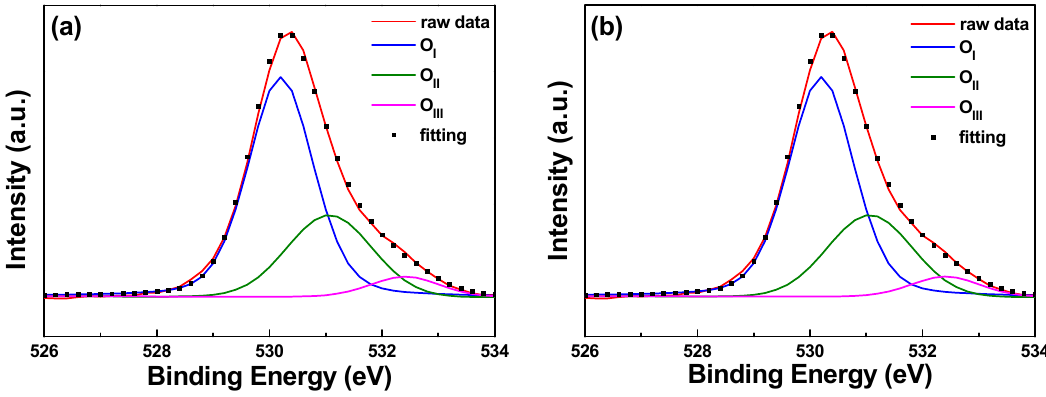
Figure 9. XPS spectra and the Gaussian-resolved components of the O 1s peak of FZO films on unmodified and 30 s pretreated PI substrates. ( a ) Unmodified and ( b ) O 2 plasma pretreatment time of 30 s. Table 1. Area of the O 1s peak of F-doped ZnO (FZO) films on unmodified and 30 s pretreated polyimide (PI) substrates.